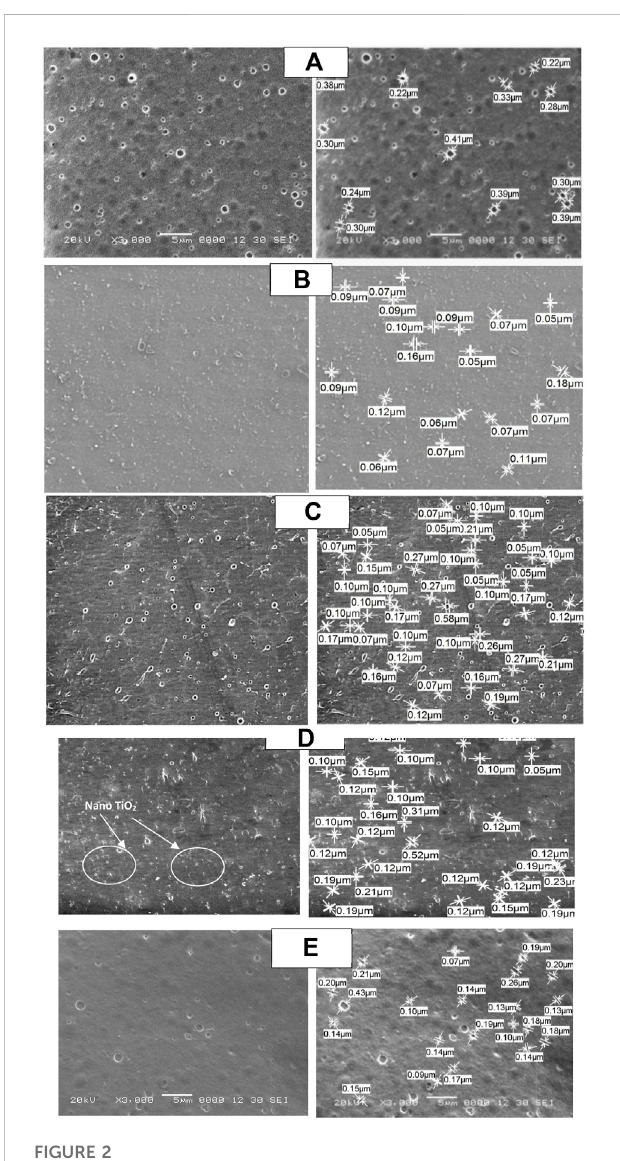
FIGURE 2 SEM micrographs of top surface (left) and pore diameter determination (right) of (A) neat CA, (B) CA/0.05 bent, (C) CA/0.1 bent, (D) CA/0.05 TiO (E) CA/0.1 TiO 2 and 2